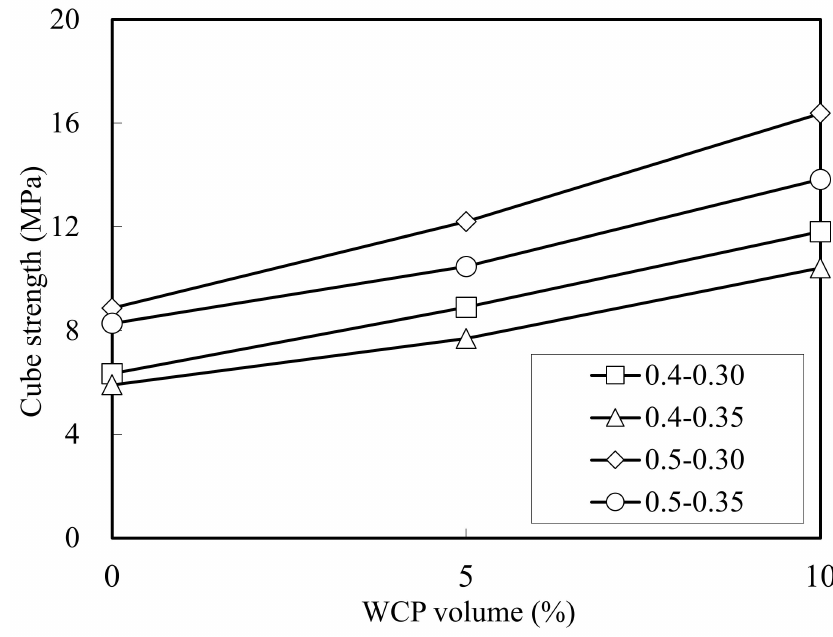
Figure 12. Variation in cube